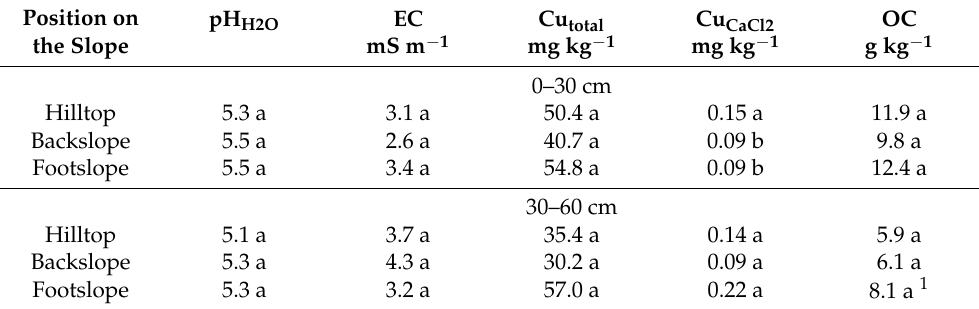
Table 1. Mean values of soil pH, electrical conductivity (EC), organic carbon (OC), total (Cu total ) and available copper (Cu cacl2 ) concentrations in soil samples taken from two soil depths (0–30 and 30–60 cm) at the location of lysimeters placement in the vineyard, i.e., at the hilltop, backslope and footslope (inter- and intra-row samples were pooled). Position on pH H2O EC Cu total Cu CaCl2 the Slope